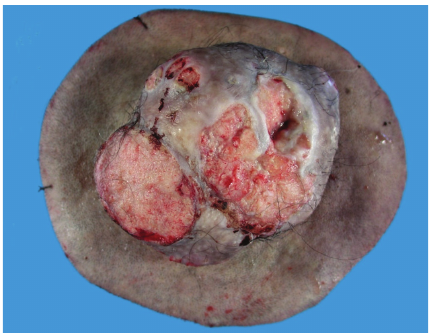
Figure 17: Proliferating tricholemmal tumor: macroscopic photo- graph showing a circumscribed cutaneous reddish-pink nodular tumor with surface